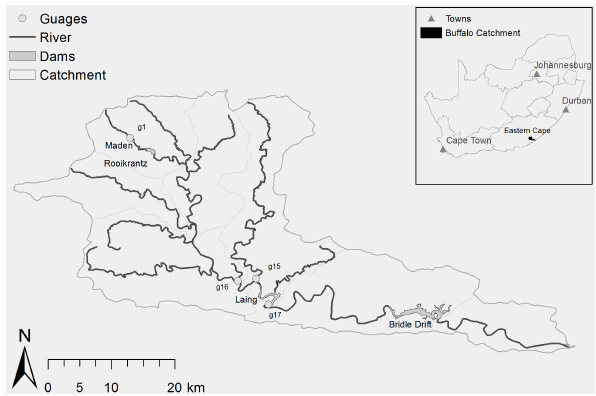
Figure 1. Map of Buffalo River Catchment within the Eastern Cape, South Africa. Water quality monitoring points used in the study for calibration of the models are indicated: g1 – Maden Dam; g16 – R20D; g15 – Yellowwoods River; g17 – Laing